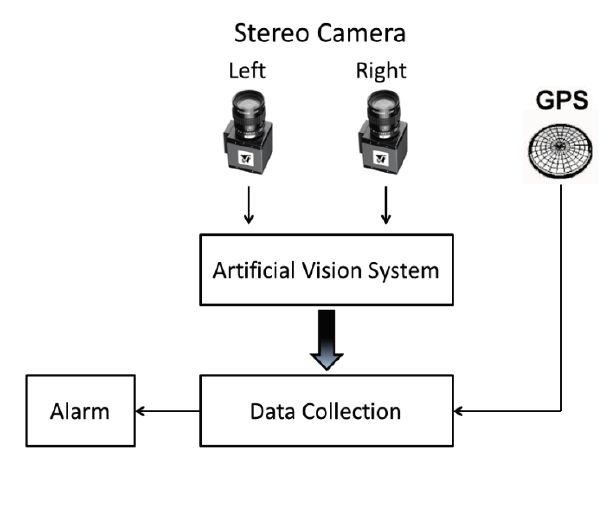
Figure 11. GPS relationship between artificial vision and GPS